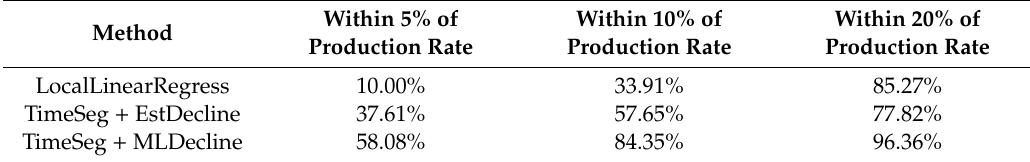
Table 4. Error distributions between the prediction and true values for three